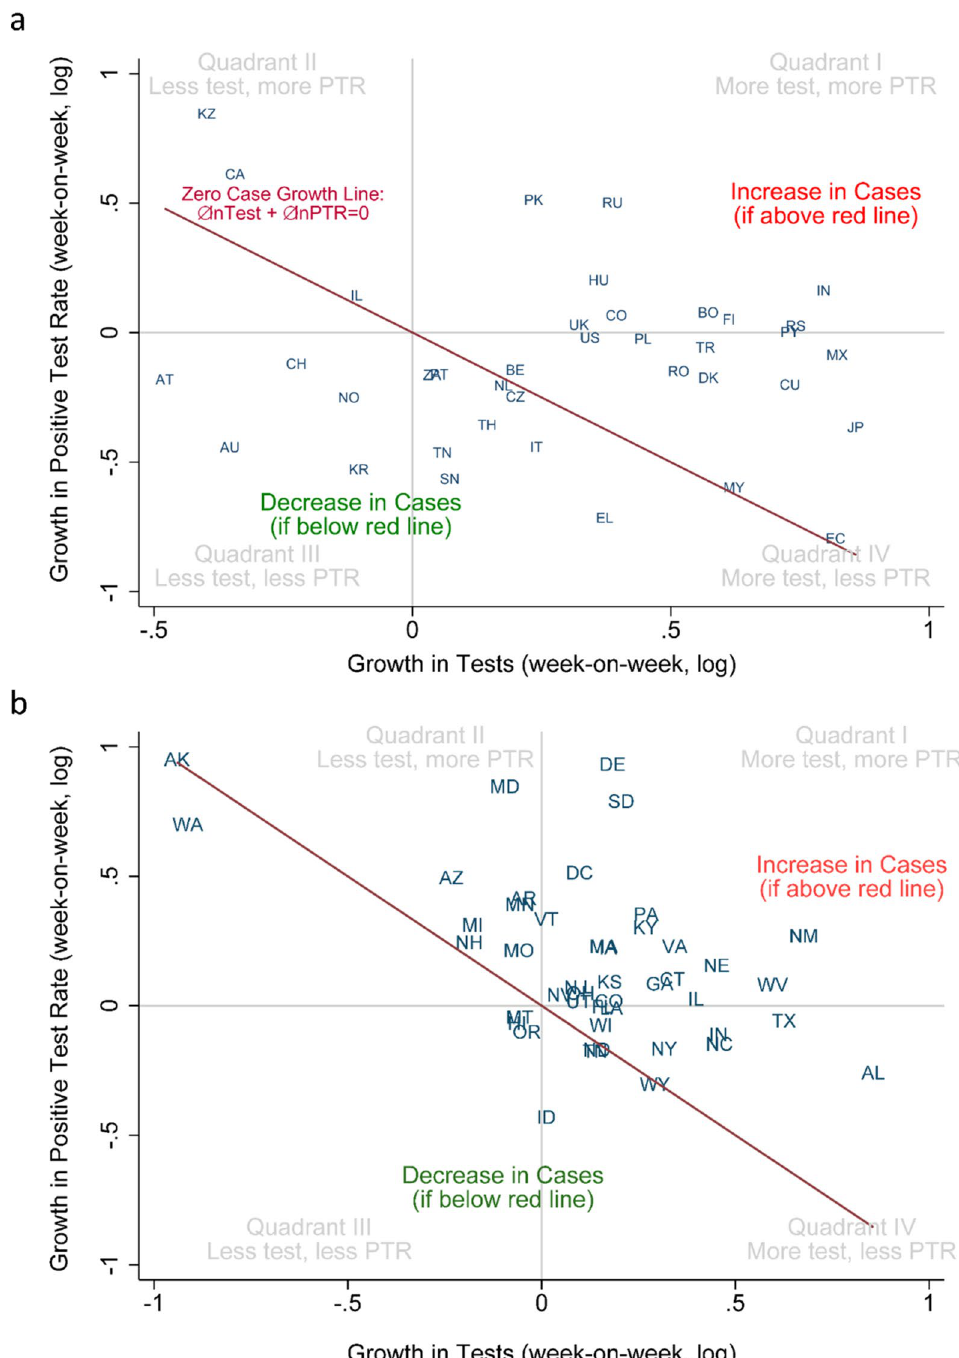
Figure 2. Growth Decomposition of Cases: Testing Growth vs. PTR Growth. Week-on-week growth of Testing and PTR across countries and US states. Points are countries ( A ) or US states ( B ). In both panels, we plot the growth of tests and PTR between the week ending April 10th and the previous week. The functional form of the previously mentioned growth is the change in the natural logarithm of per capita rates per week. The growth decomposition of cases is the sum of the increase in testing (horizontal axis) and PTR growth (vertical axis). The line is not a regression but represents zero case growth as (cid:31) ln Cases = (cid:31) ln Tests + (cid:31) ln PTR = 0 . While territories above the line have growing cases, territories below the line have decreasing cases. The four quadrants (I to IV) in gray show the various combinations of increasing or decreasing testing and PTR. Notably, quadrants (II) and (IV) include growing and declining cases, depending on the side of the zero-case growth line. For instance, in ( B ), KY appears with decreasing cases but is associated with fewer tests and more PTR. The opposite combination happened in ( A ) for Ecuador. For visual purposes, countries in A were restricted to a pop > 5 million people, and US states in ( B ) exclude WA. Countries are represented by ISO 3 codes and US states by two-digit codes. The supplementary material shows how the USA moved over several weeks in the cross-country plot. Names and abbreviations for countries and US States are included in the Supplementary